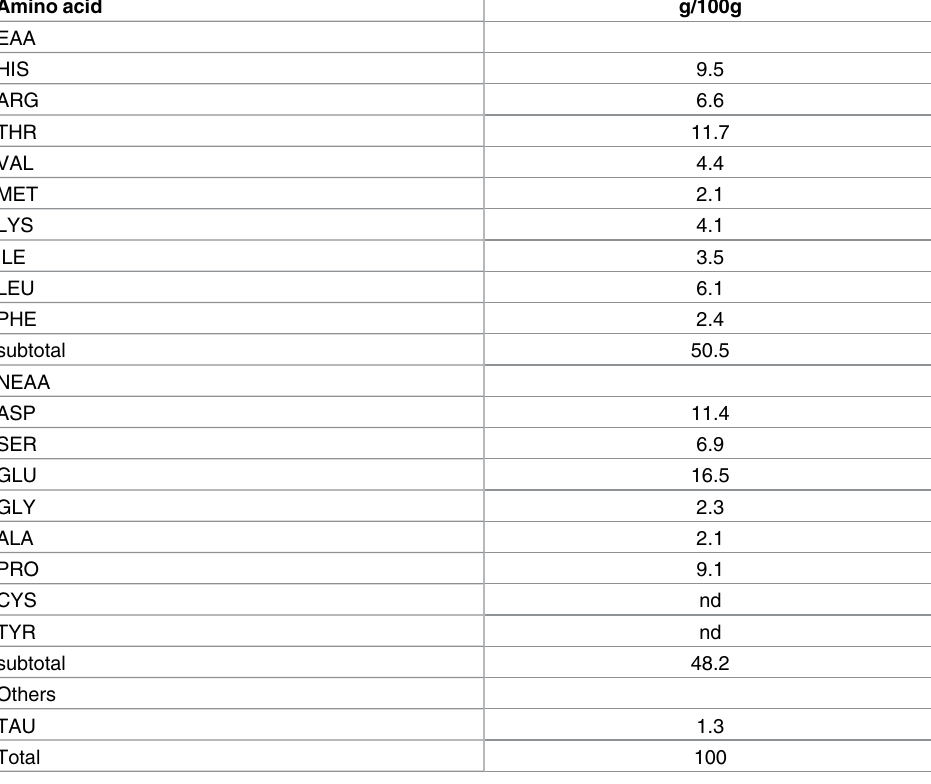
Table 1. Amino acid profile from control diet used to equilibrate the isotopic signature of S . lalandi and used by the control group.